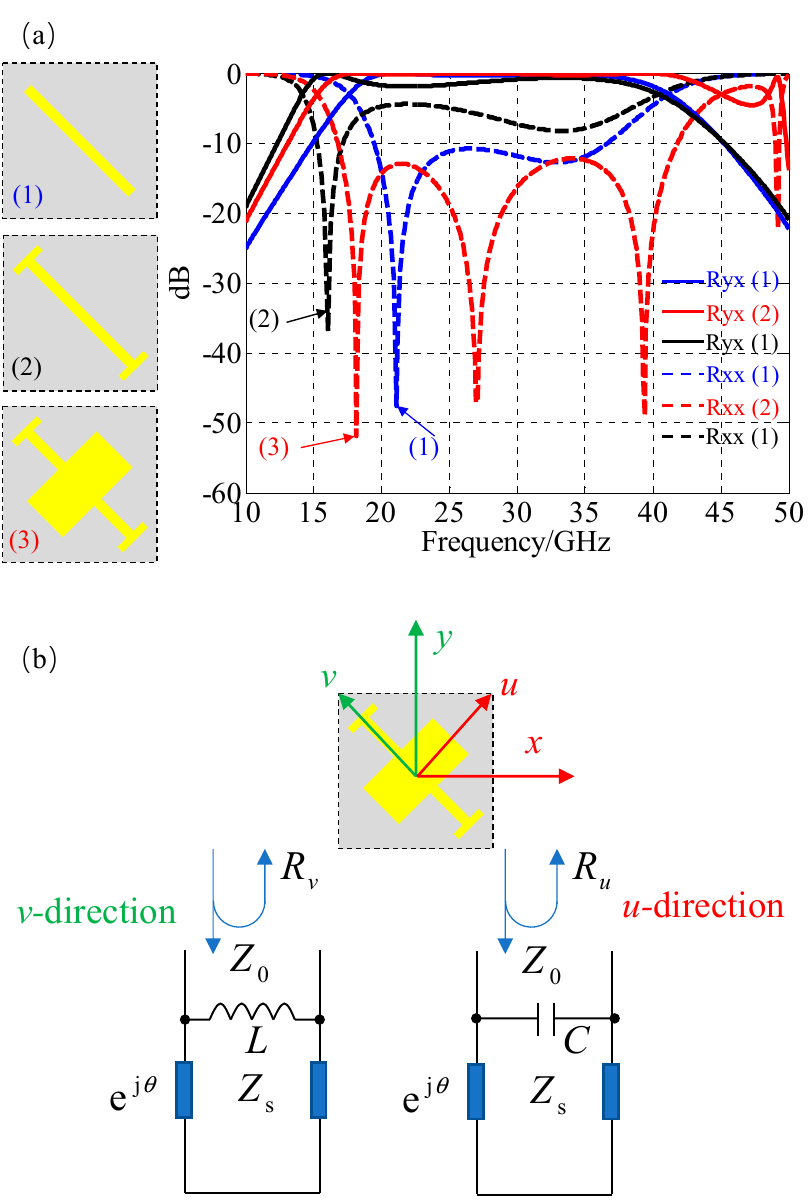
Figure 3. The evolution of the design and the equivalent circuit. ( a ) Evolution process: design (1) is a skewed strip array; design (2) is an end-loaded array; and design (3) is further loaded in the middle with a patch; ( b ) Equivalent circuit. The v -direction is an inductive effect; the u -direction is a capacitive effect.